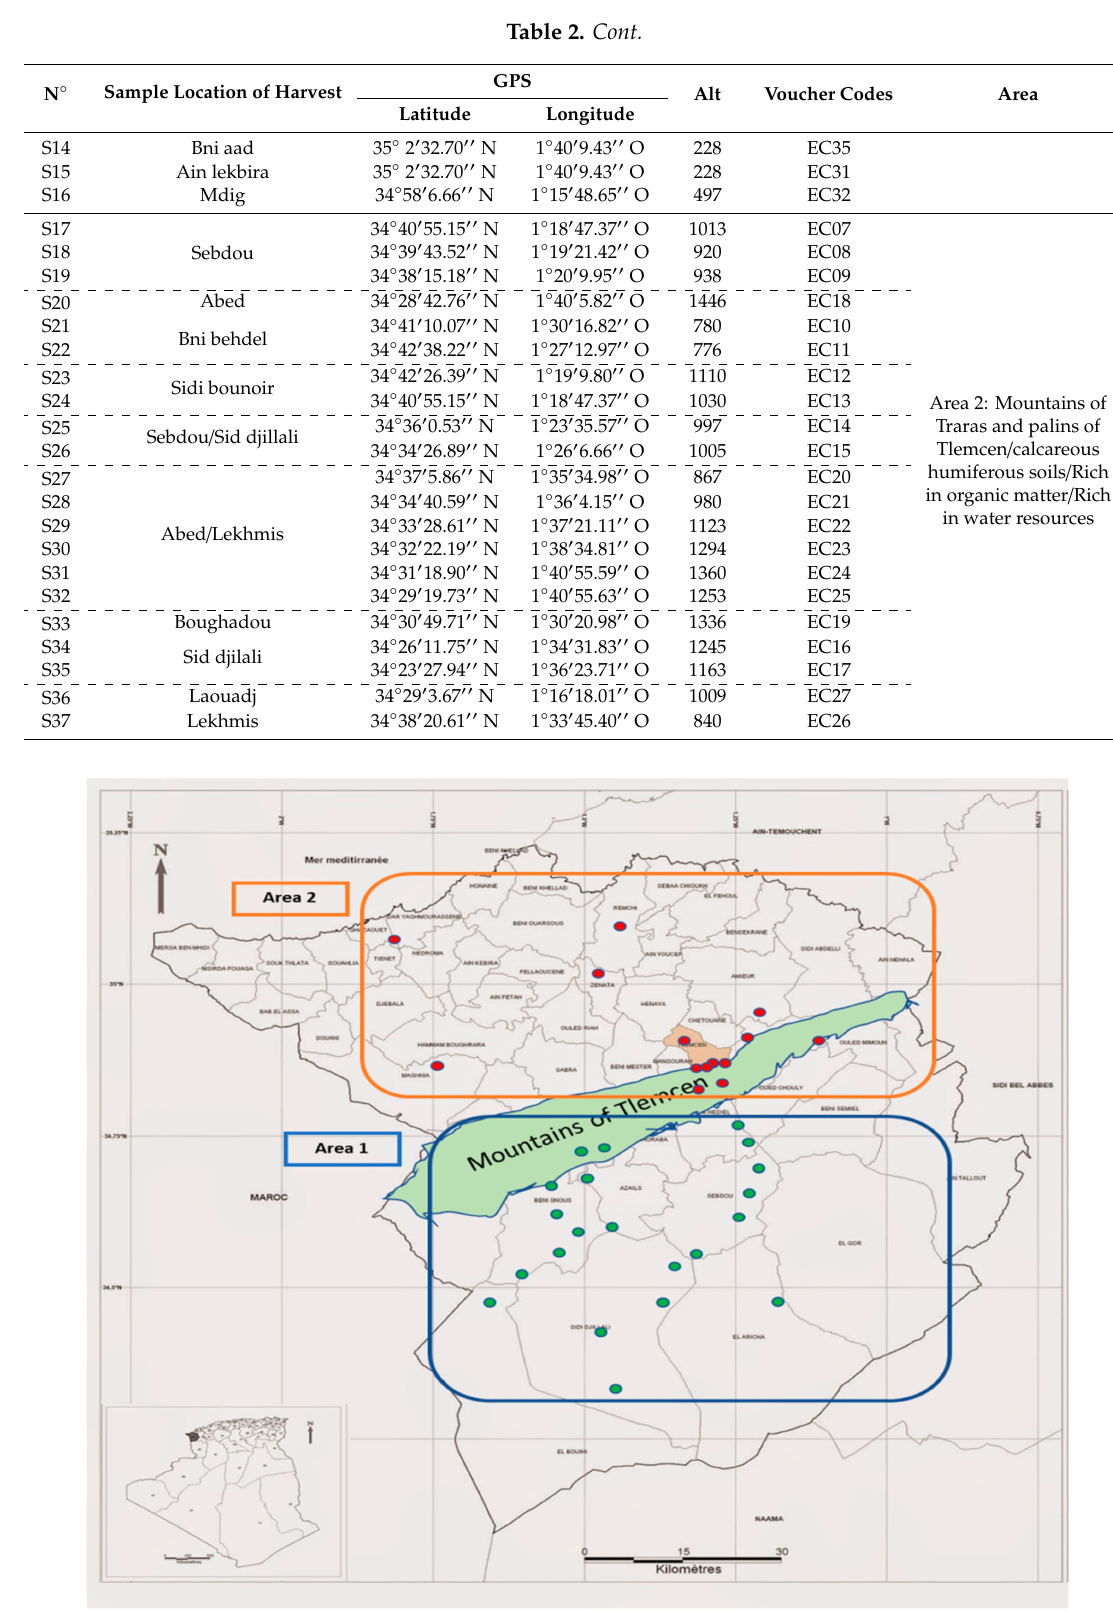
Figure 1. Geographical localization of the Algerian Eryngium campestre samples (see Table 2 for more